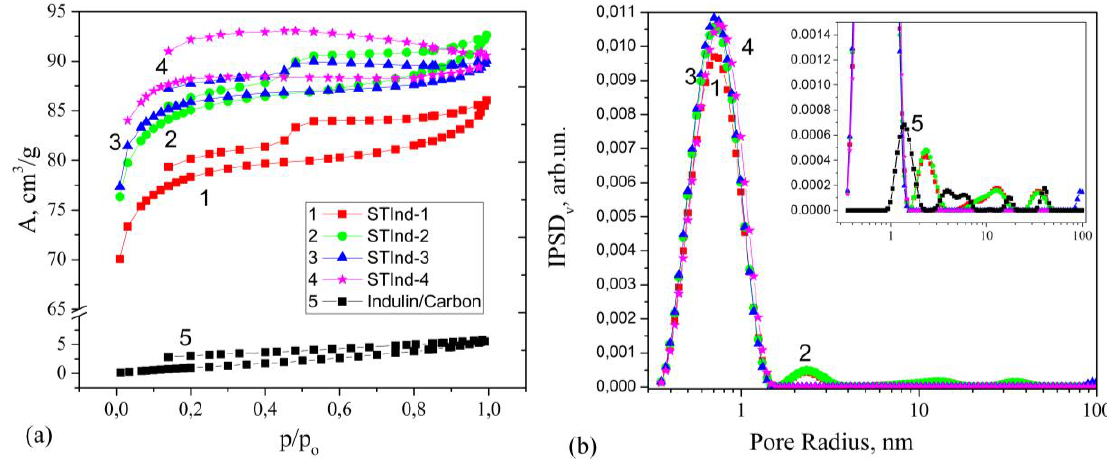
Figure 1. ( a ) Nitrogen adsorption – desorption isotherms and ( b ) pore size distributions of 1: